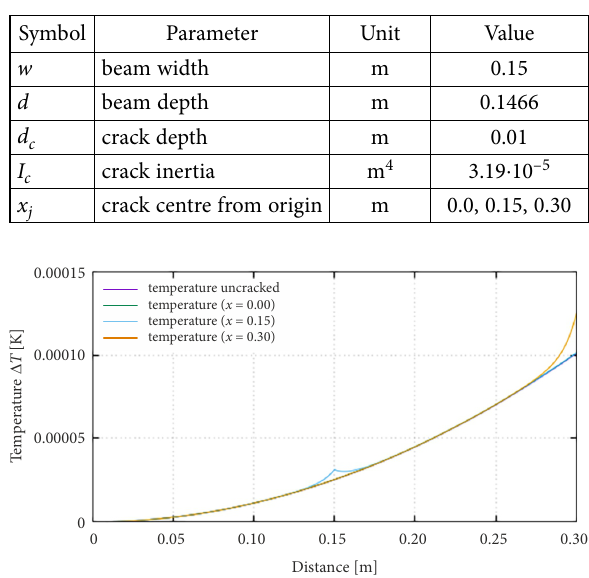
Figure 15. Change in temperature due to cracks and